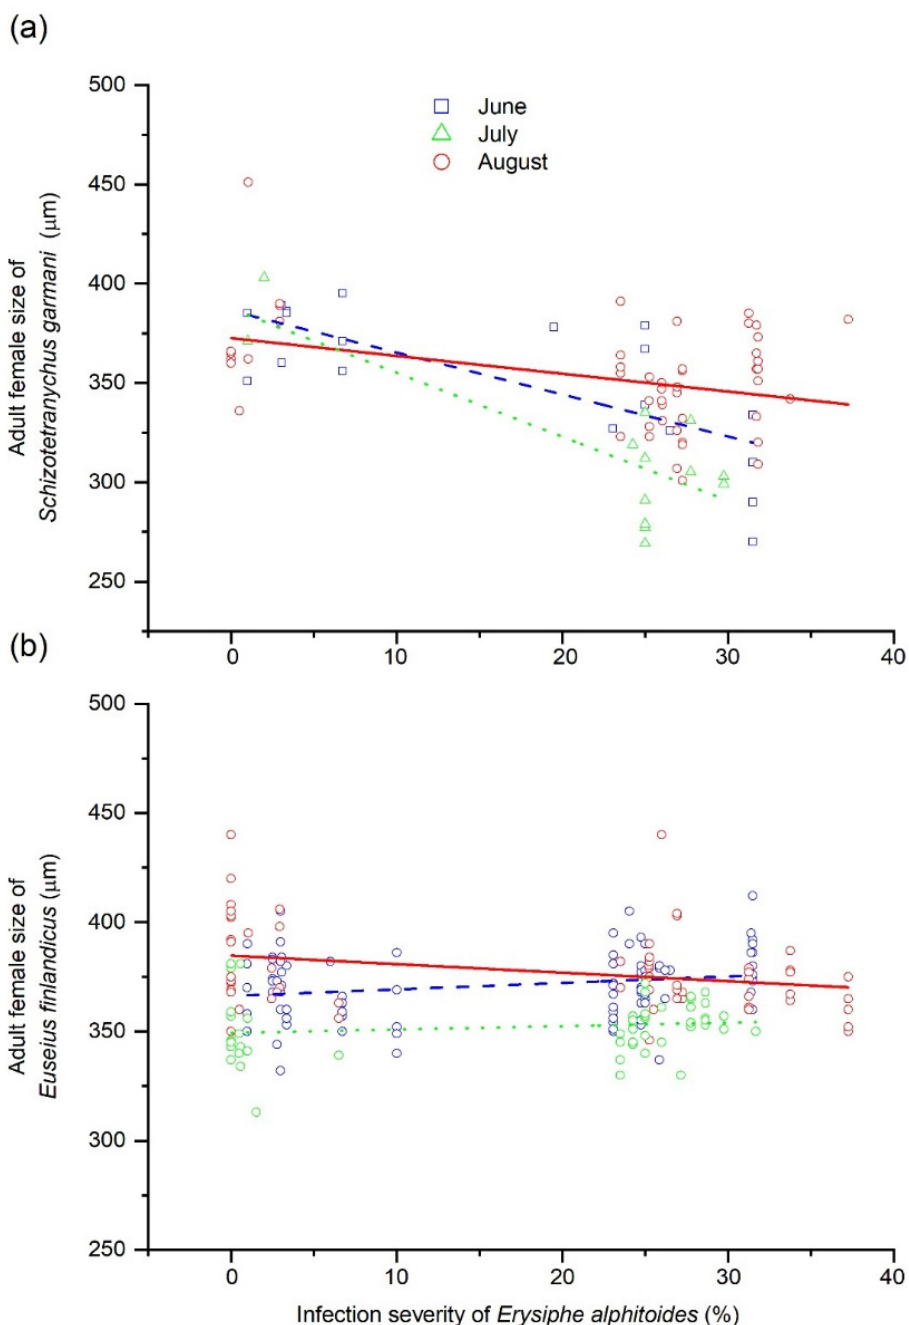
Figure 4. Relationships between severity of powdery mildew ( Erysiphe alphitoides) in Quercus robur leaves and adult female idiosoma size of ( a ) the phytophagous mite Schizotetranychus garmani or ( b ) the predatory mite Euseius finlandicus . Severity ranged from 0 to 100, corresponding to an infected leaf area percentage of 0 to 100%. Circles, squares and triangles represent mean values at the tree level for June, July and August, respectively.